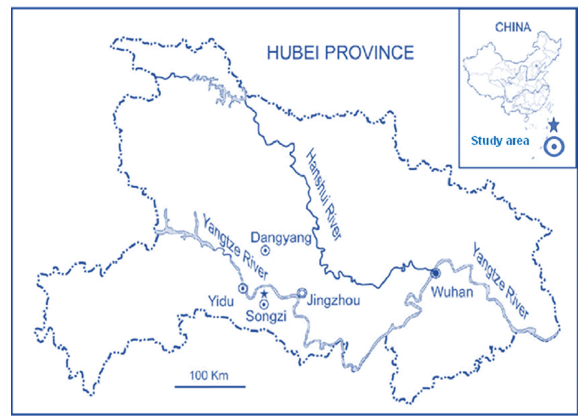
Figure 1: Location map of the studied limestone mine sample site in China.